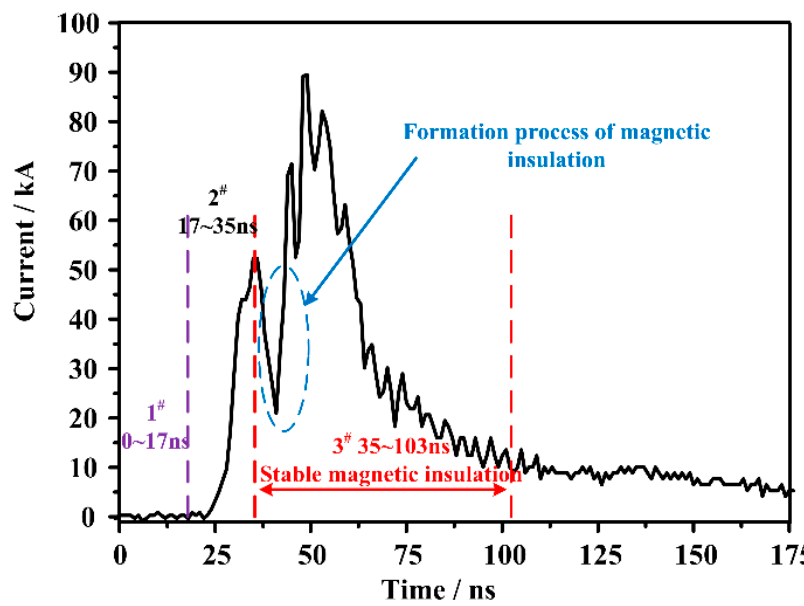
Figure 9. Electron beam waveform obtained by full absorption Faraday cup. According to the changing process of the pulse voltage with time, the working process of the MITL–electron beam diode power coupling system was divided into four stages.